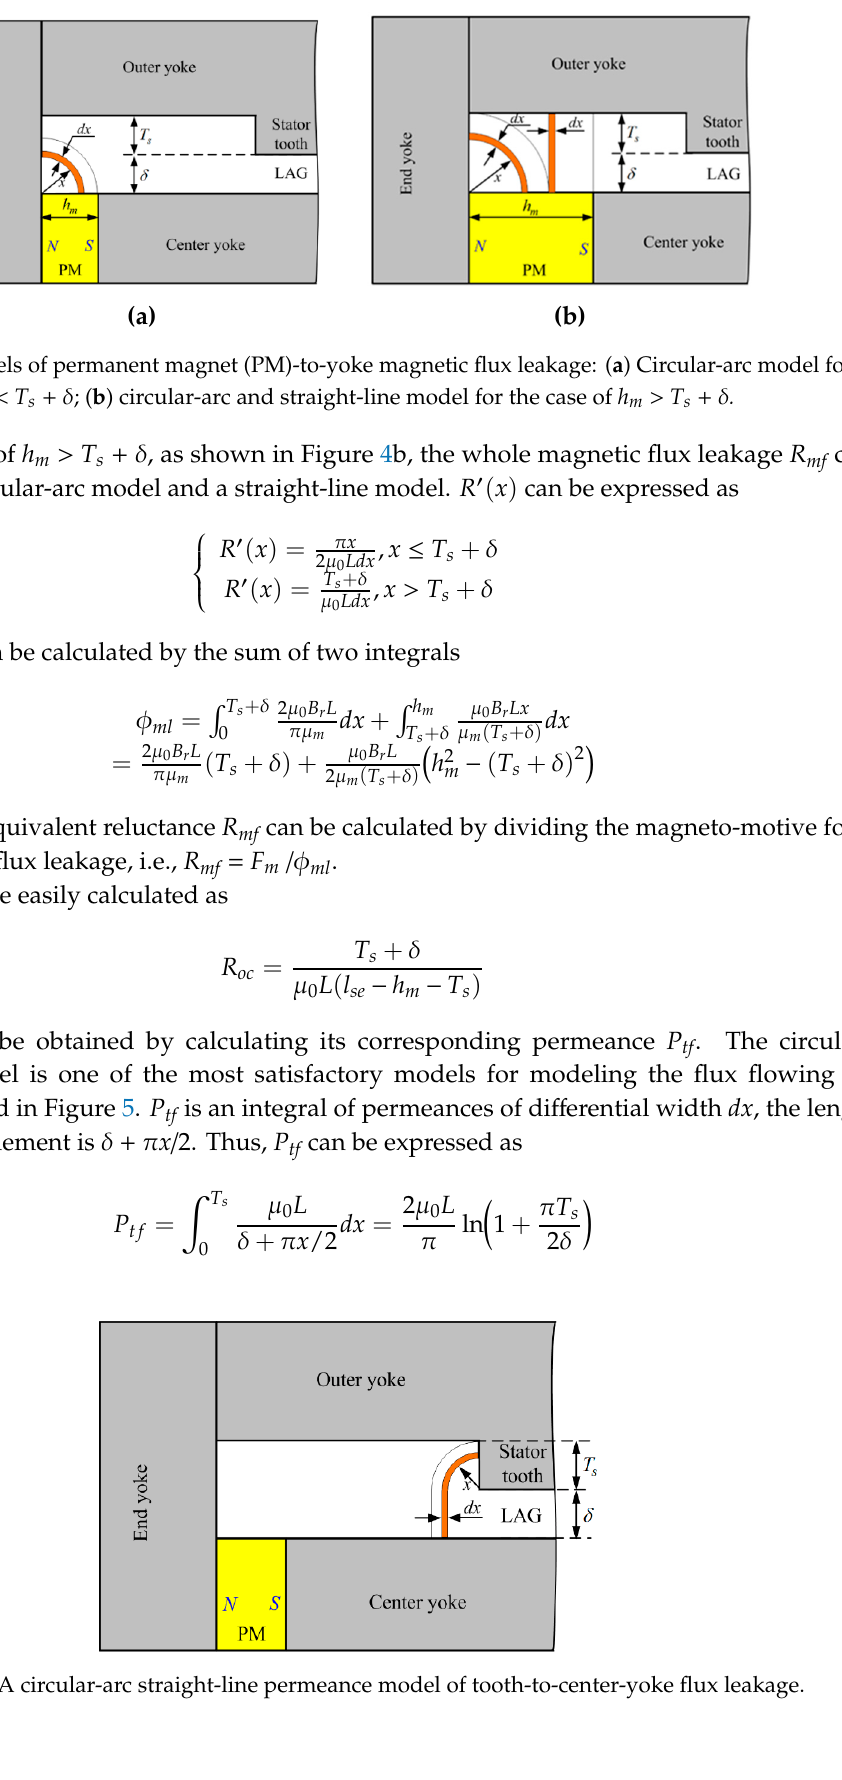
Figure 6. This improved model can yield accurate analytical results of the MFD in long air gaps. Figure 6. Improved LPMEC model for the RCDMC. The N + 7 closed loops L i ( i = 1, 2, … N + 7) are defined with the direction marked in Figure 6. According to Kirchhoff’s law, the following equations can be obtained by 1